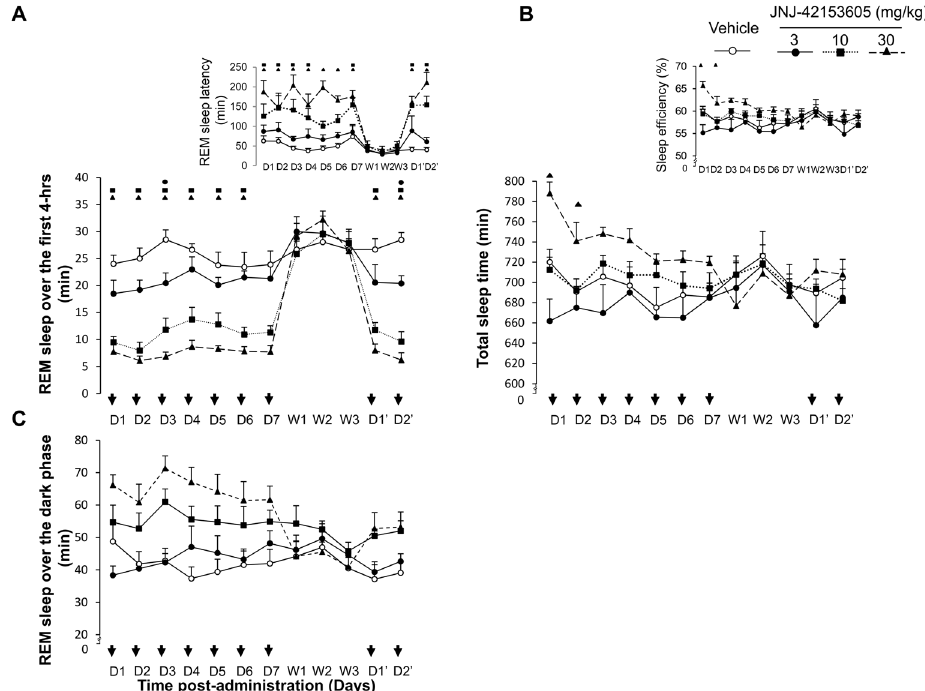
Fig 6. Sleep parameters following repeated dosing with JNJ-42153605 (3, 10, 30 mg/kg) or vehicle on experimental days (D1 first treatment day till D7 seventh treatment day), withdrawal days (W1 first withdrawal day till W3 third withdrawal day) and re-administration days after withdrawal (D ’ 1 and D ’ 2). Total sleep time expressed in minutes (Panel A) and sleep efficiency expressed in percentage (Panel A upper inset). REM sleep amount during the first 4-h of recording session after repeated administration (Panel B) and REM sleep latency (Panel B upper inset). Total amount of REM sleep expressed in minutes that was recovered during the subsequent 10-h dark period (Panel C). The data are presented as means ± S.E.M. Significant differences between the vehicle and JNJ-42153605 group are indicated by the drug-dose